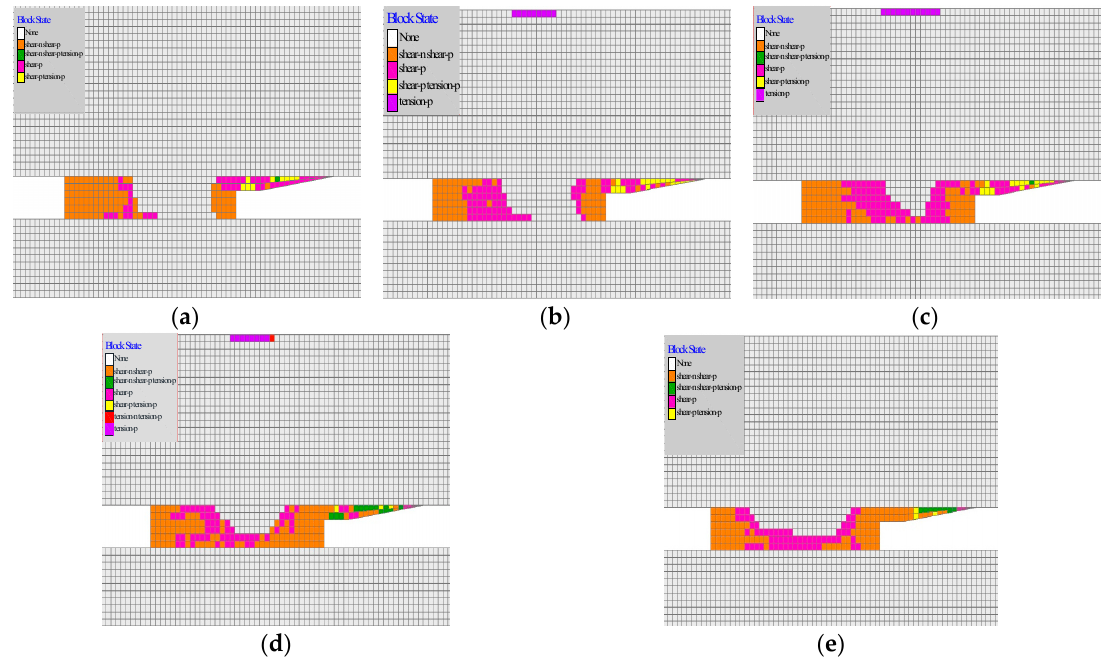
Figure 15. The schematic diagram of the plastic zones during the excavation of the coal face at ( a ) 40 m, ( b ) 60 m, ( c ) 80 m, ( d ) 100 m, and ( e ) 120 m.